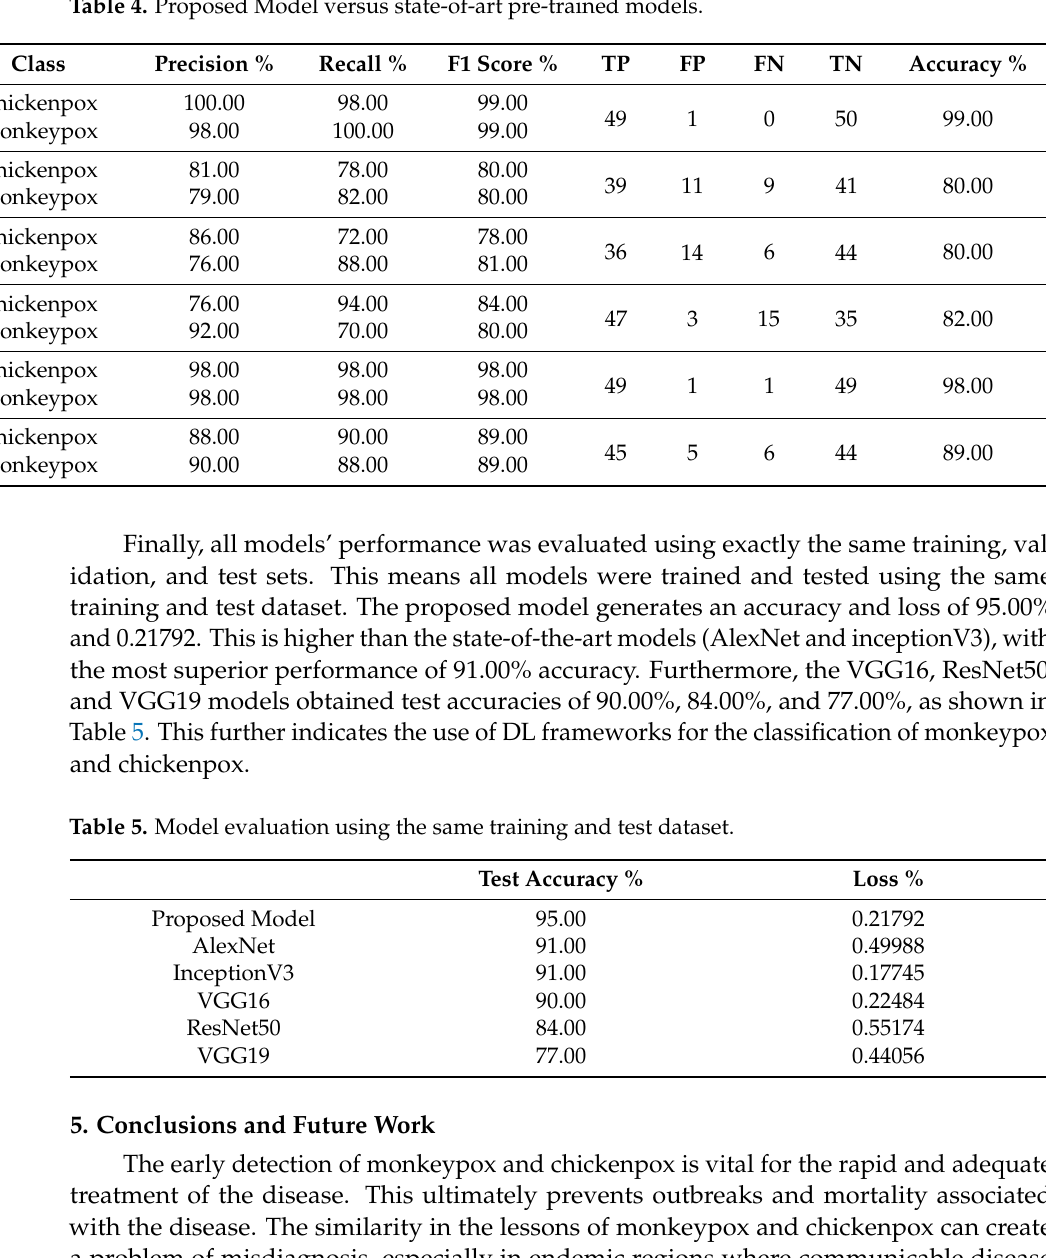
Table 4. Proposed Model versus state-of-art pre-trained models.